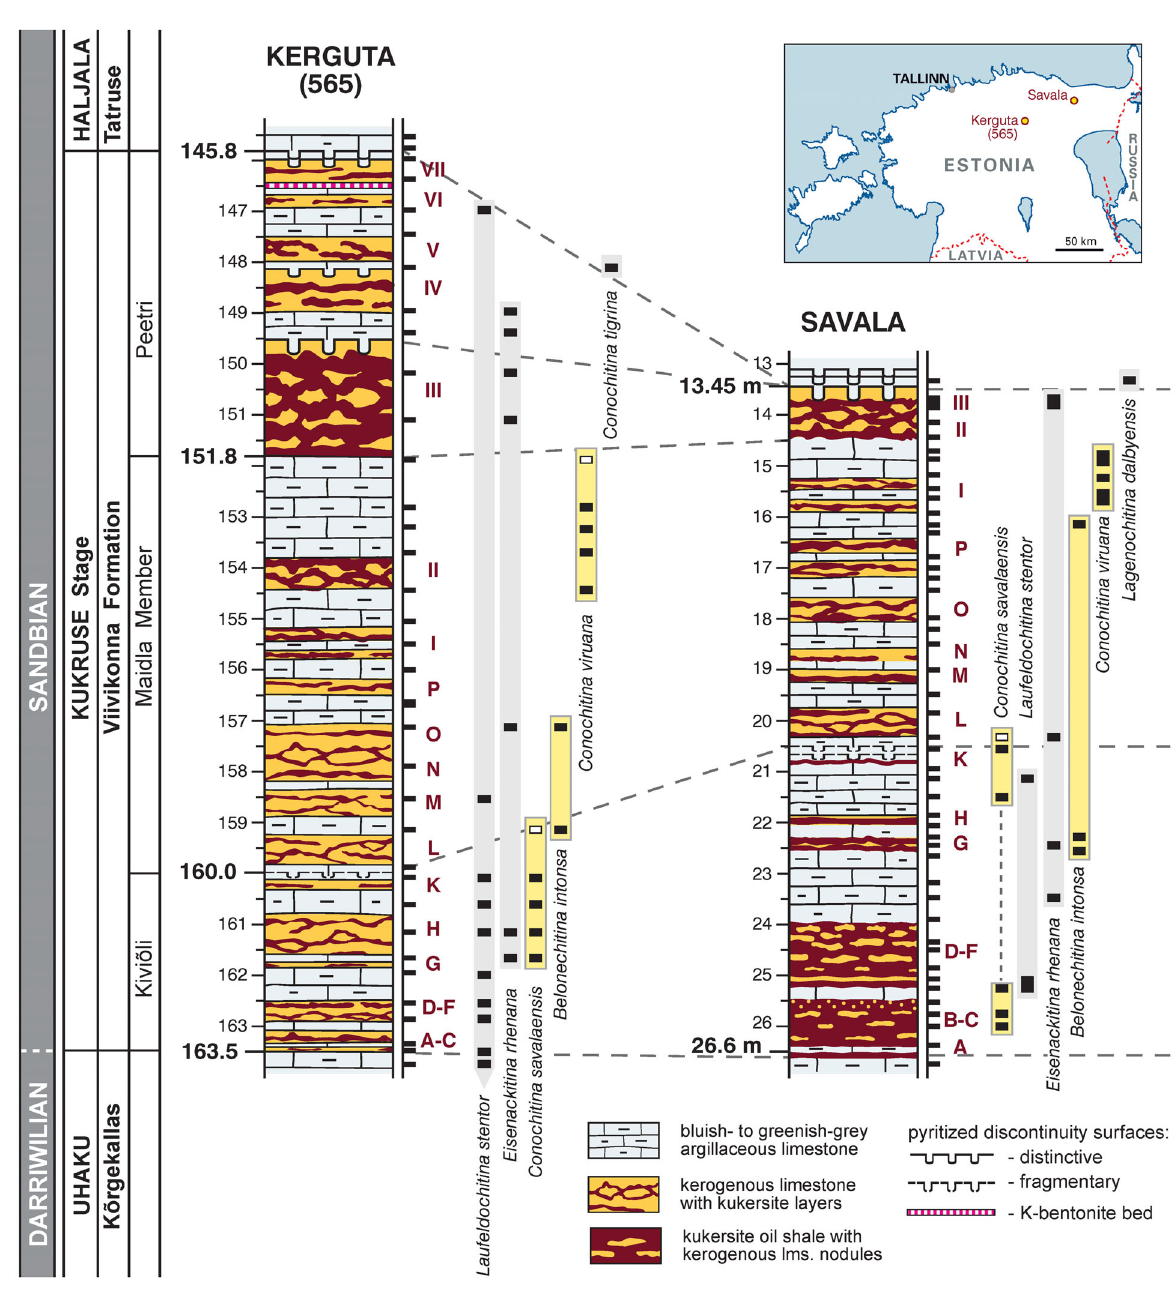
Fig. 1. Distribution of new and selected stratigraphically important chitinozoan species in the Kukruse Regional Stage in the Savala and Kerguta (565) core sections. A–P and I–VII are kukersite bed indexes. Empty boxes in the species range lines mean identifications with open nomenclature